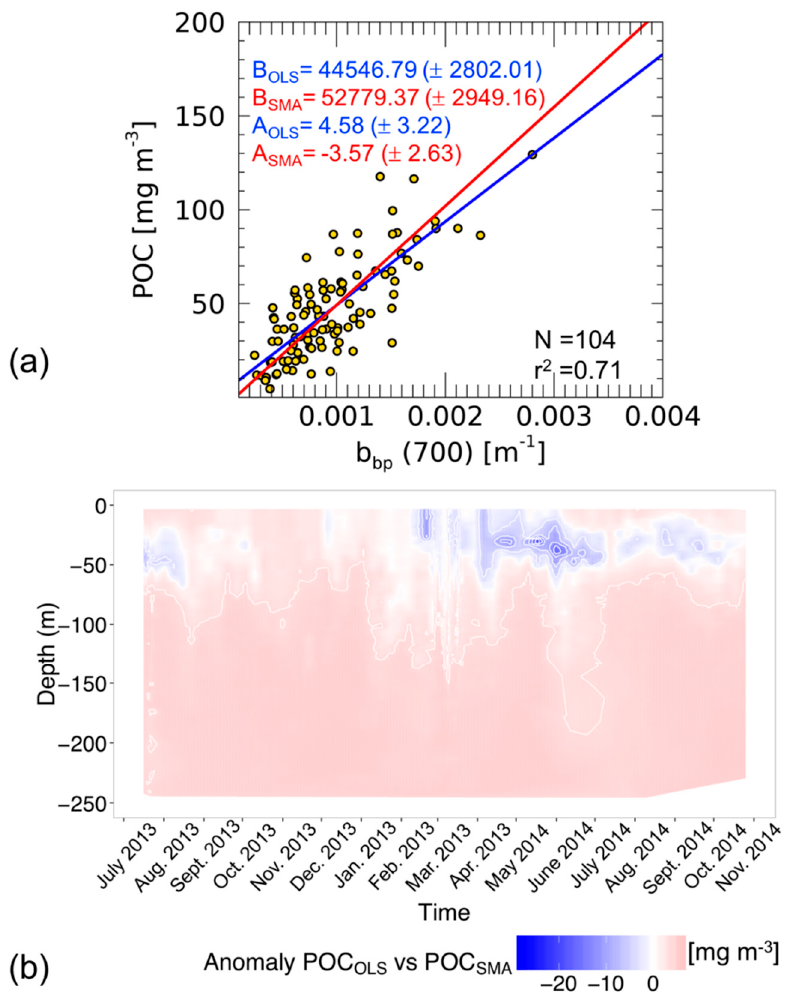
Figure 4. Scatter-plot and linear fits calculated with OLS (blue) and SMA (red) methods in the b bp -POC relationship at the BOUSSOLE site ( a ). For both the coefficients, intercepts (A) and slopes (B), the standar errors are also indicated. Time series anomalies of particulate organic carbon (POC) derived from BGC-Argo b bp vertical profiles (0–250 m) using OLS and SMA and relationships ( b ).